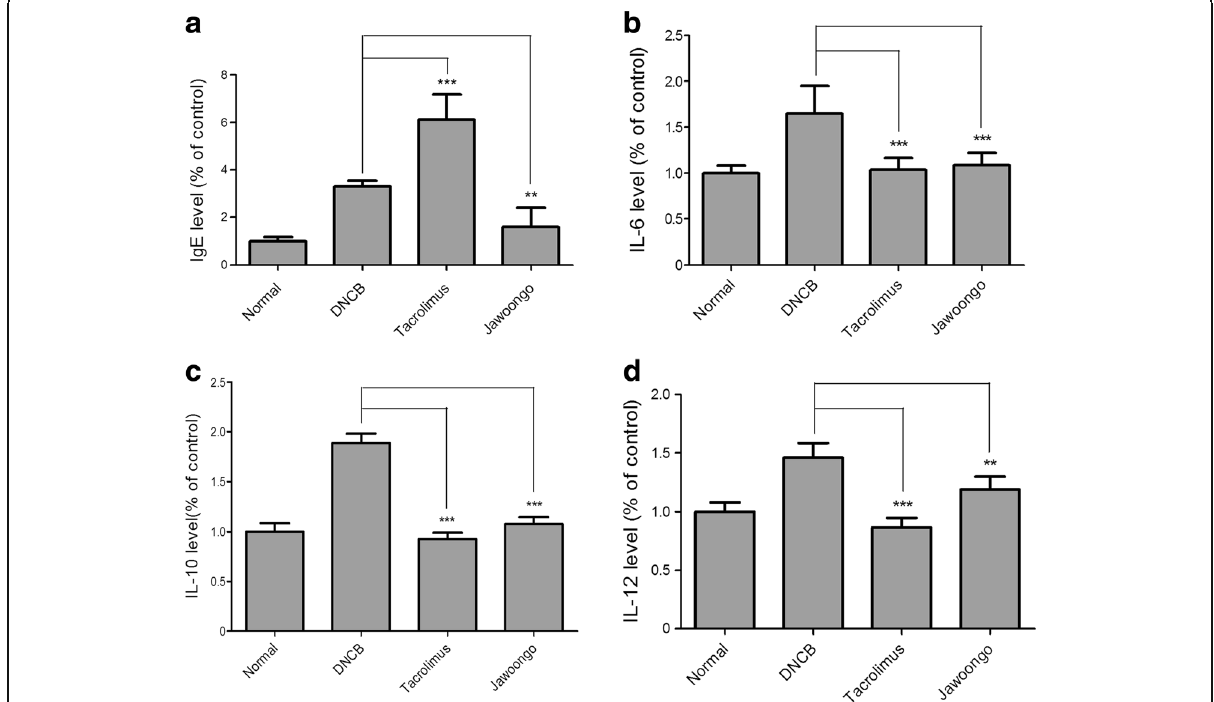
Fig. 4 Jawoongo reduced cytokine levels in serum. Cytokine levels were measured by ELISA. The data were presented as mean ± SEMs ( n = 8 mice/group). * P < 0.05, ** P < 0.01 and *** P < 0.001 as compared to DNCB-stimulated group,